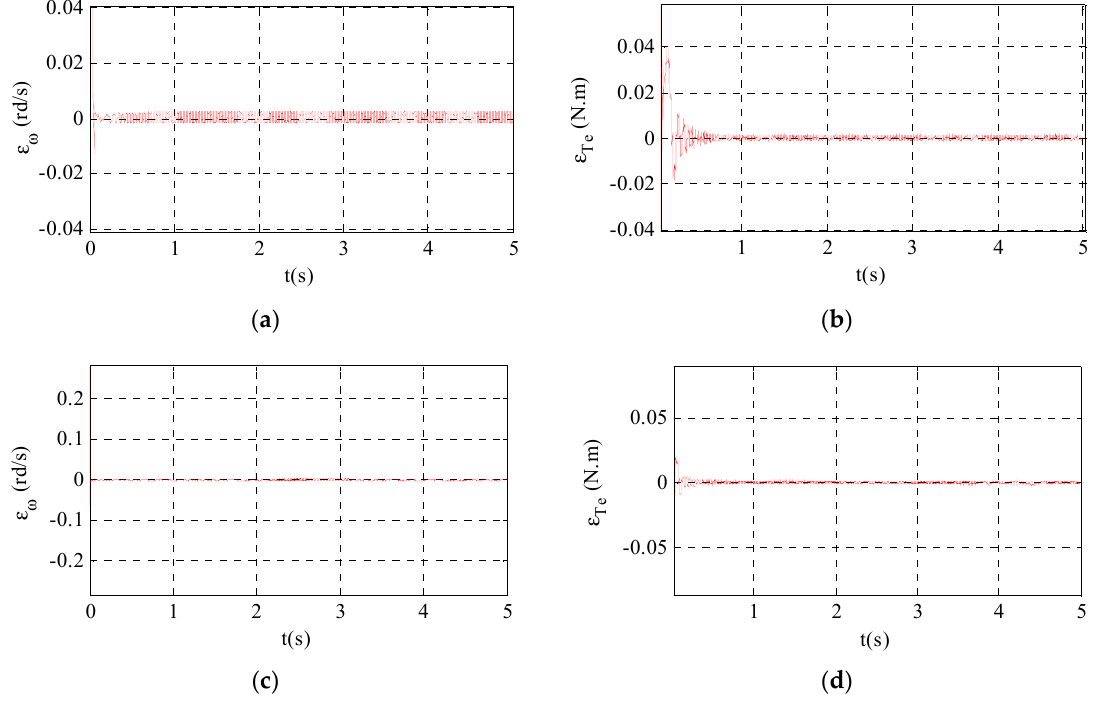
Figure 13. Error rates collection between reference and actual: ( a ) speeds under constant wind profile; ( b ) torques under constant wind profile; ( c ) speeds under variable wind profile and ( d ) torques under variable wind profile.